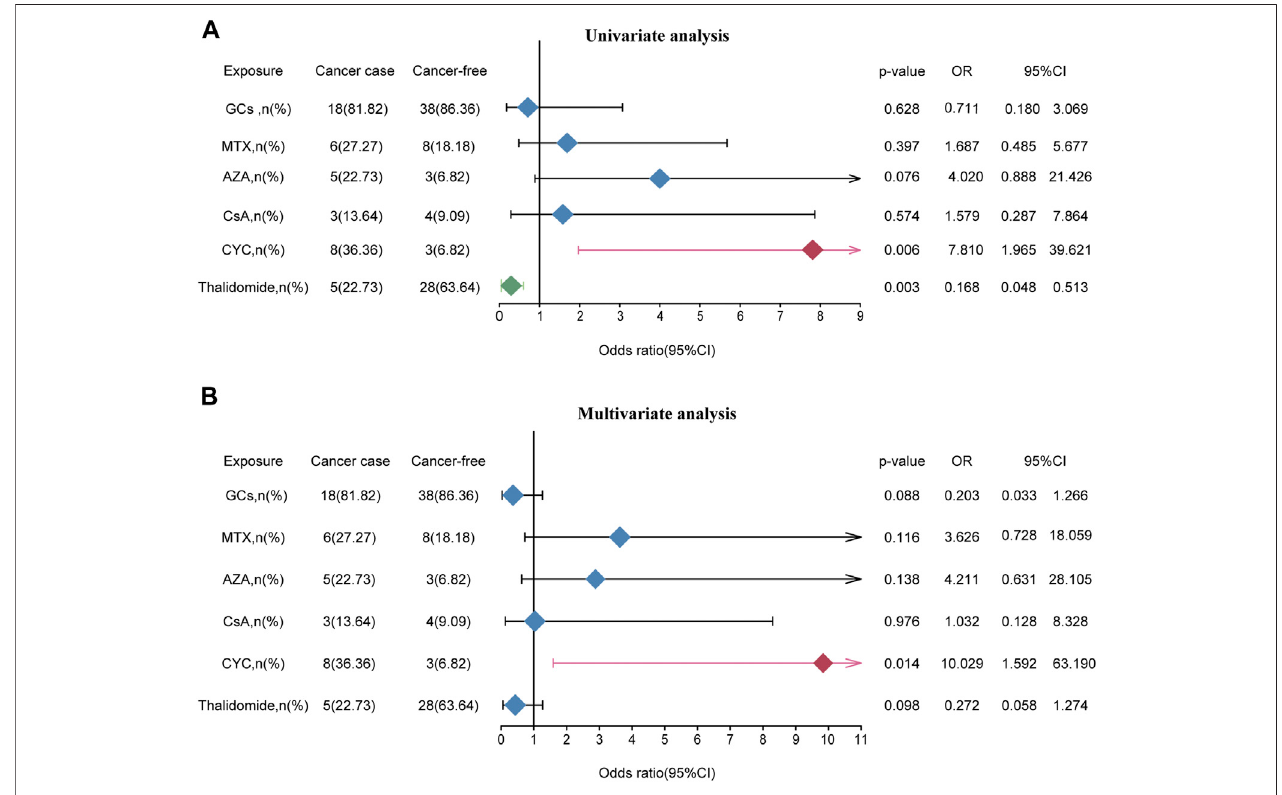
FIGURE 3 | The effect of medication exposure on cancer risk in patients with BD. (A) Univariate analysis between medication exposure and cancer risk. (B) Multivariate analysis between medication exposure and cancer risk. Abbreviations: GCs, glucocorticoids; MTX, methotrexate; AZA, azathioprine; CsA, cyclosporine; CYC, cyclophosphamide; OR, odds